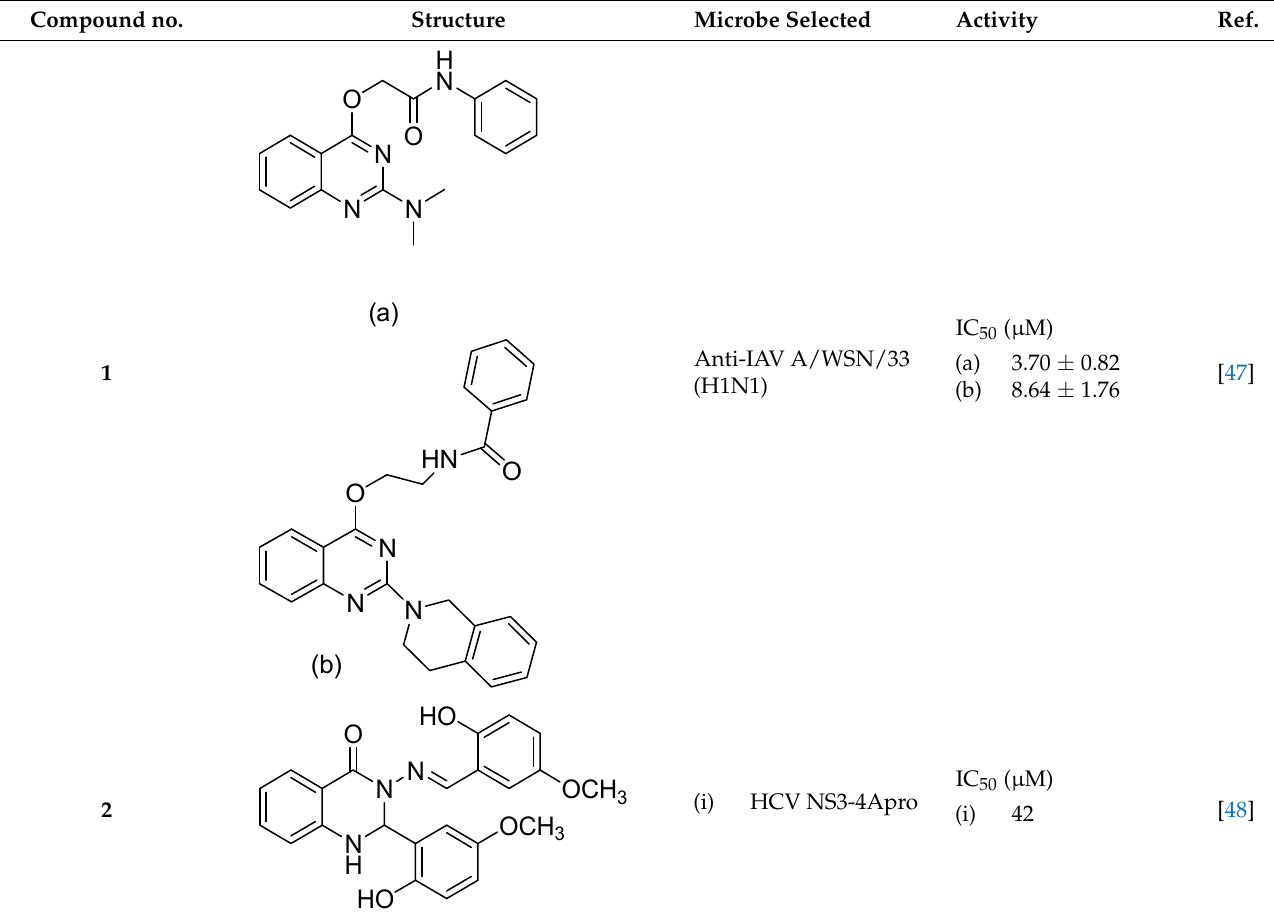
Table 3. Antiviral activity of quinazoline derivatives.